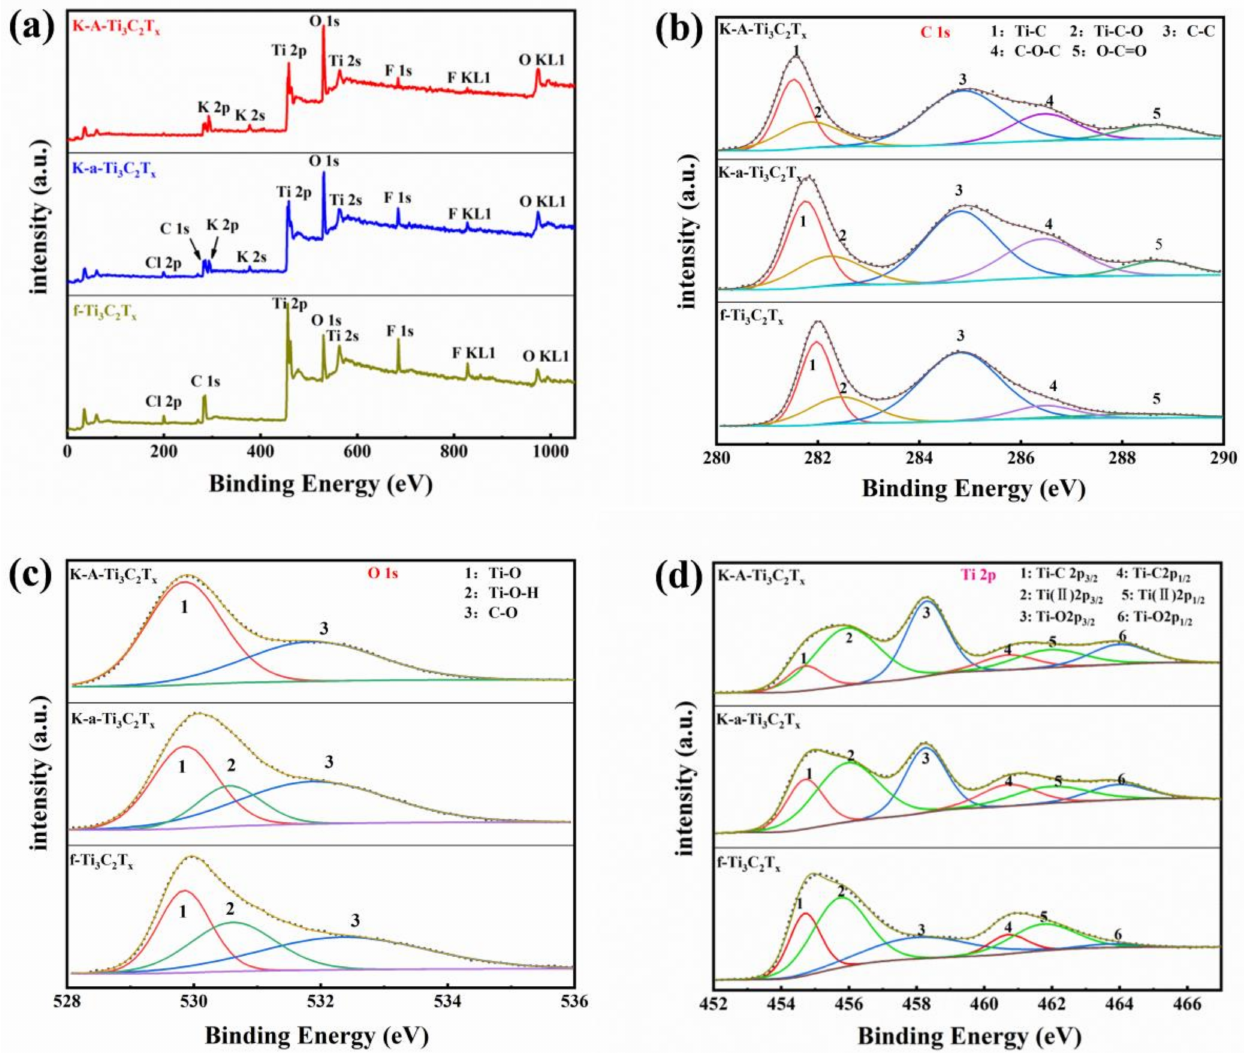
Figure 4. XPS results of f-Ti 3 C 2 T x , K-a-Ti 3 C 2 T x , and K-A-Ti 3 C 2 T x : ( a ) full spectrum, ( b ) C 1s spectra, ( c ) O 1s spectra, and ( d ) Ti 2p